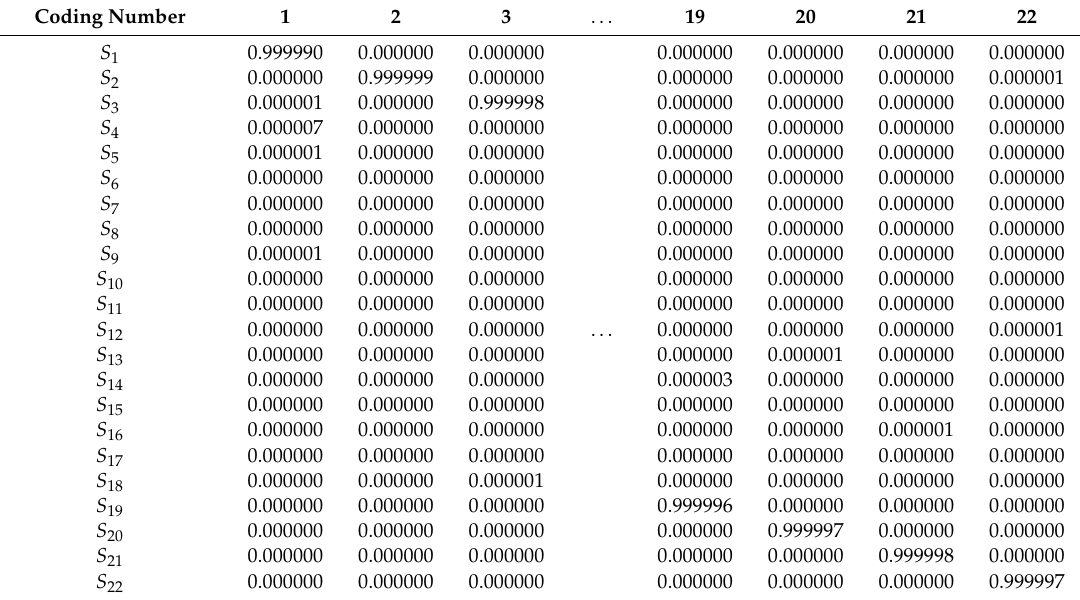
Table 4. The probability output results of Softmax and corresponding failure coding number. Coding Number